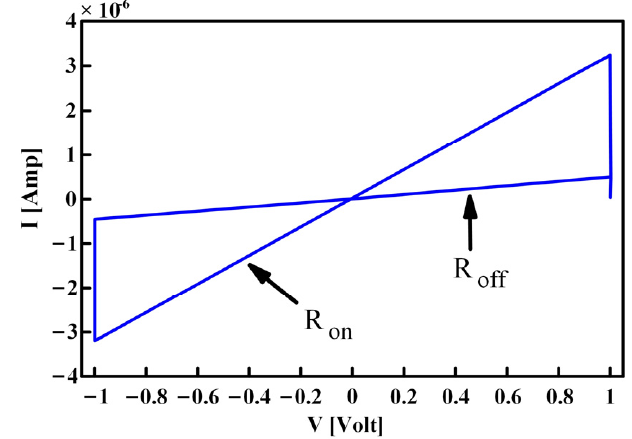
Figure 6. Improved NDR hysteresis unit hardware circuit and its experimental result: ( a ) improved NDR hysteresis unit hardware circuit, ( b ) experimental result.